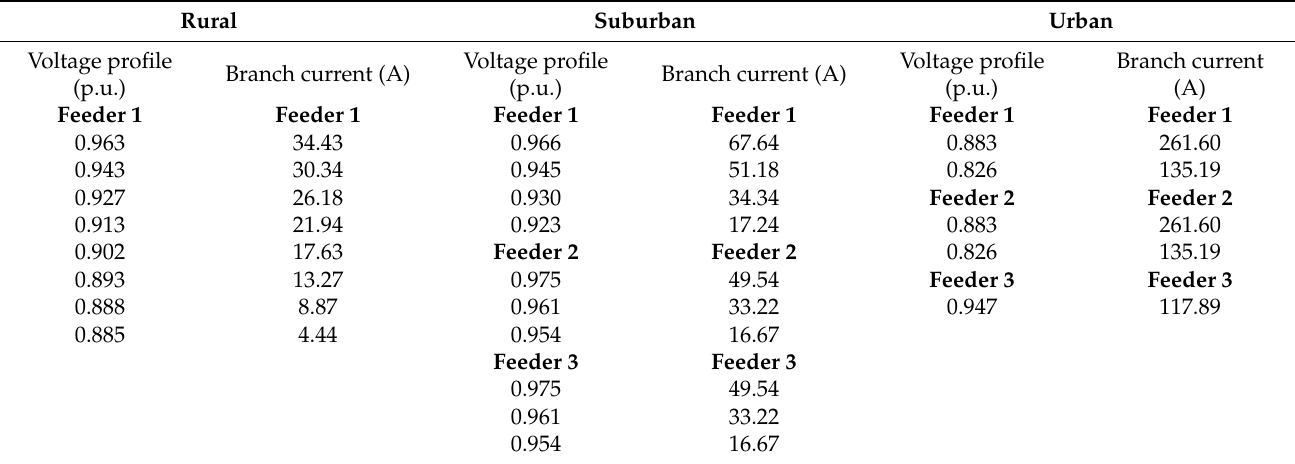
Table 5. Voltage and current profiles of three regions with initial cable selection of smallest size before upgrading the cables for optimal network formation. Rural Suburban Urban Voltage profile